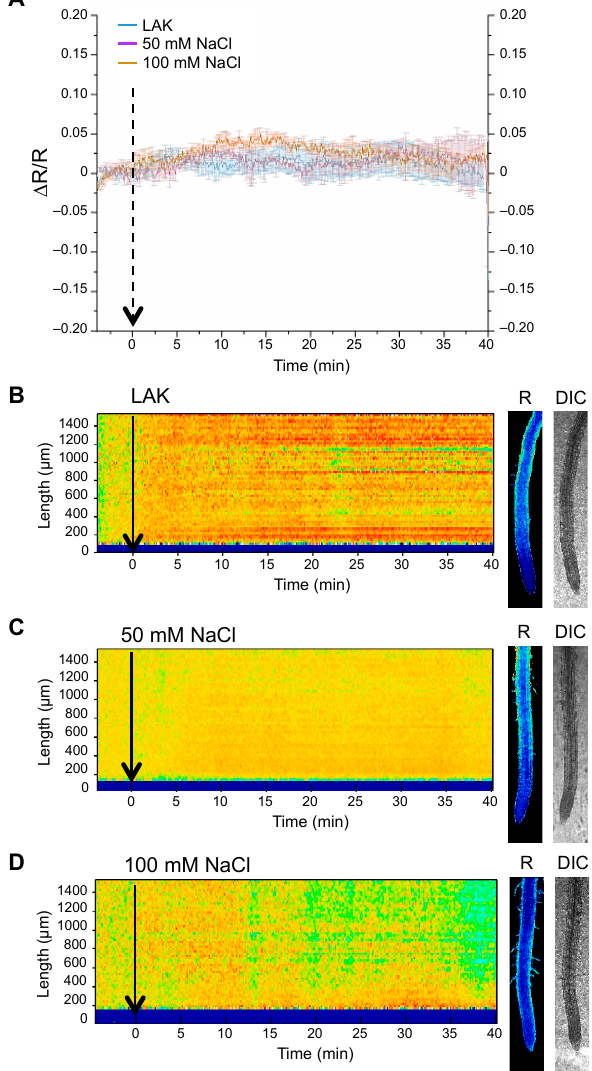
Figure 7. Cytosolic pH variations under salt stress reported by pHGFP-LTI6b in the sos3 mutant. Seedlings of the sos3-1 mutant expressing the pH-sensor pHGFP-LTI6b were treated with either LAK medium ( B ) or the same medium supplemented with 50 mM NaCl ( C ) or 100 mM NaCl ( D ) and the variations in pHcyt were measured. ( A ) Normalized emission ratio ( Δ R/R); lines indicate the mean of emission ratio of the MEZ sector ± SEM from 5 to 6 seedlings. ( B , C , D ) Heat-maps of normalized data derived from 64 adjacent sections (268.2 × 24.2 μ m) according to the position scale on the left. On the right are shown fluorescence (R) and bright-field (DIC) images at time point 35 min. Heat-maps and root micrographs correspond to representative experiments. Arrows in all panels indicate the time the treatment started.